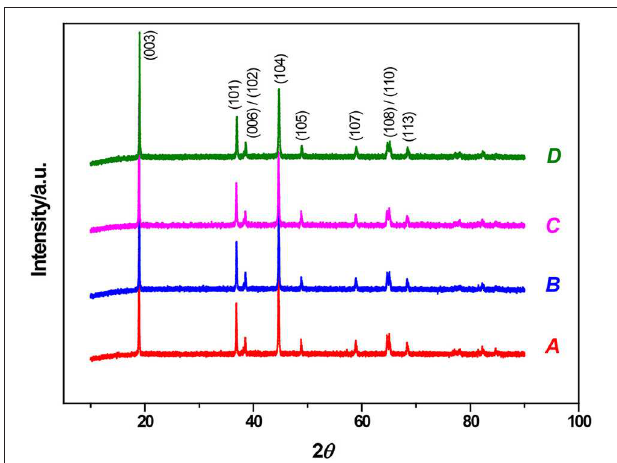
FIGURE 2 | XRD patterns of NCM811 Samples (A-uncoated, B-Coated by Al2O3, C-Coated by ZrO2, D-Coated by LBO).